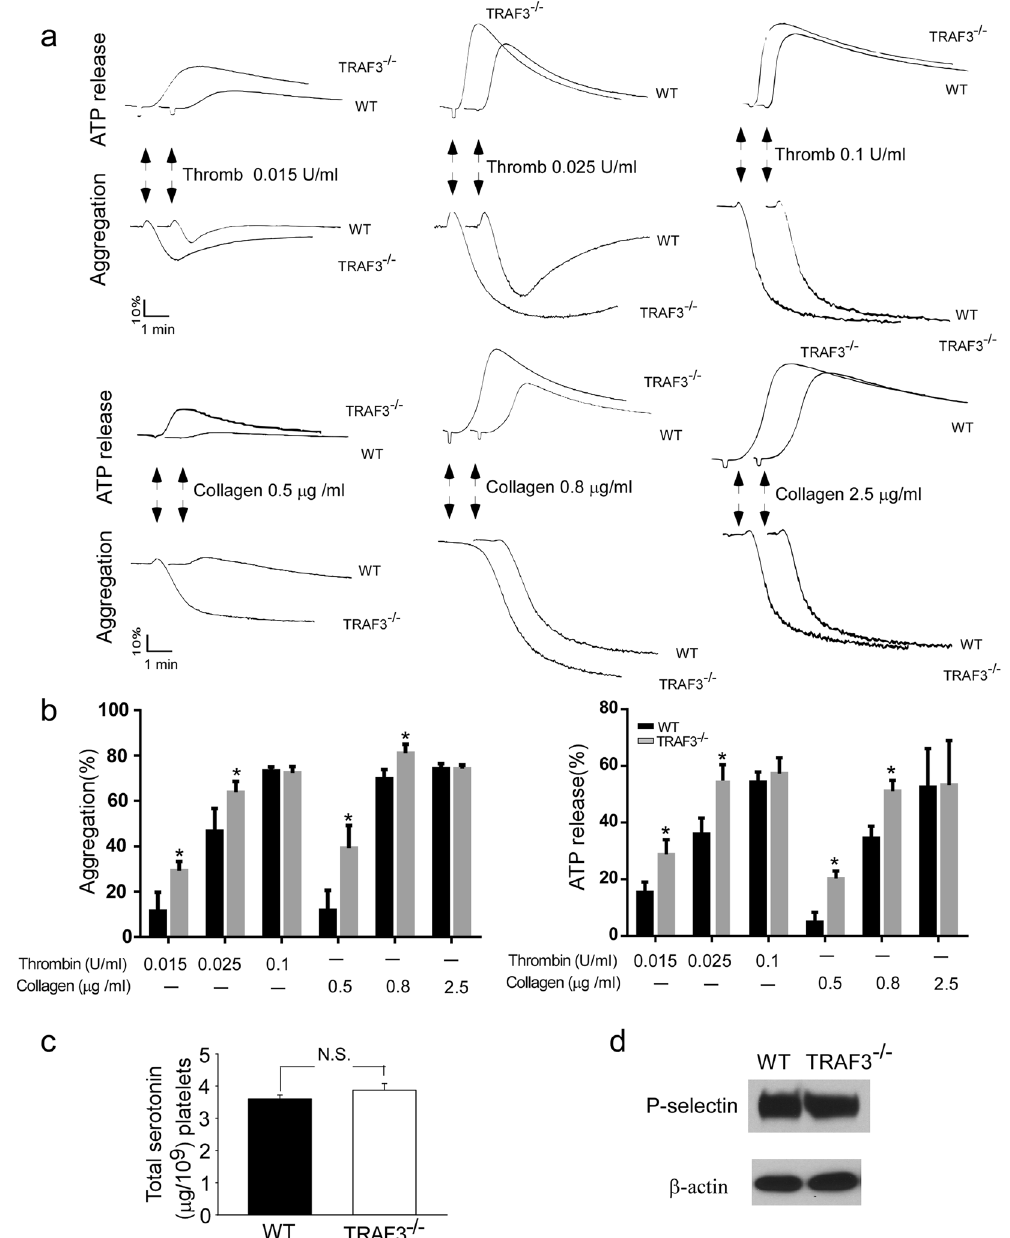
Figure 2. Platelet secretion and aggregation are defective in the TRAF3 knockout mice. ( a ) Washed platelets from TRAF3 knockout mice (TRAF3 − / − ) or wild-type littermates (TRAF3 + / + ) were stimulated with various concentrations of thrombin or collagen and simultaneously recorded for ATP secretion and aggregation. The aggregation and ATP release traces are representatives of at least three different experiments. ( b ) Aggregation and ATP secretion results in the experiments described in A were quantitated. ( c ) Total serotonin in 1 × 10 9 TRAF3 + / + and TRAF3 − / − platelets from four mice with each genotype was measured by O-phthalaldehyde assay as described under “Experimental Procedures” (n = 4). ( d ) Detection of P-selectin in platelet lysates from TRAF3 + / + and TRAF3 − / − mice by Western blot (n =